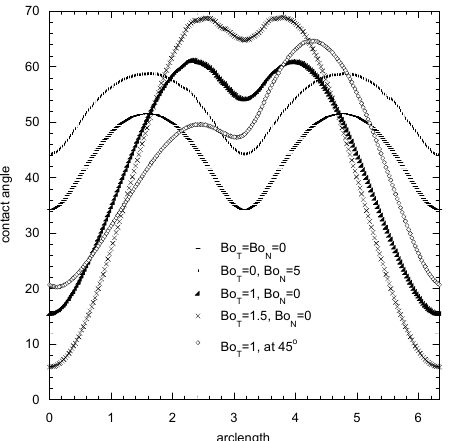
Figure 2. Contact angle (degrees) distribution along a pinned elliptical contact line (aspect ratio = 1.5) for several values of normal and tangential Bond numbers. Dimensionless volume V = 0.6.